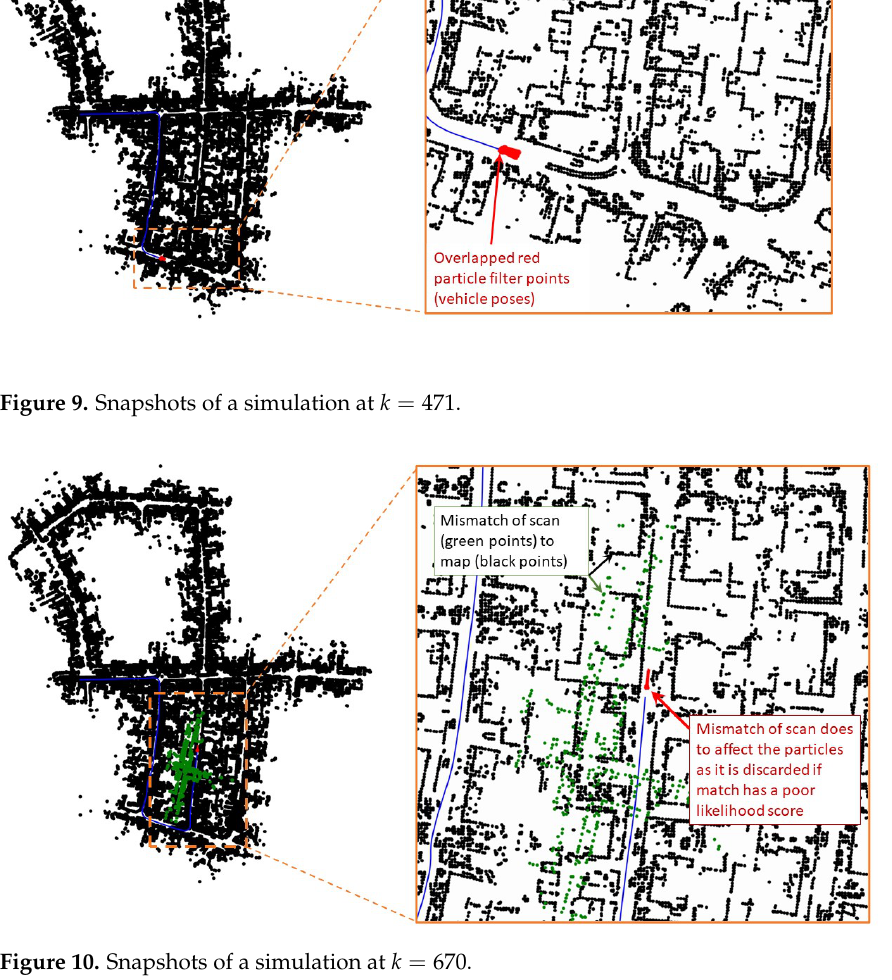
Figure 10. Snapshots of a simulation at k = 670.